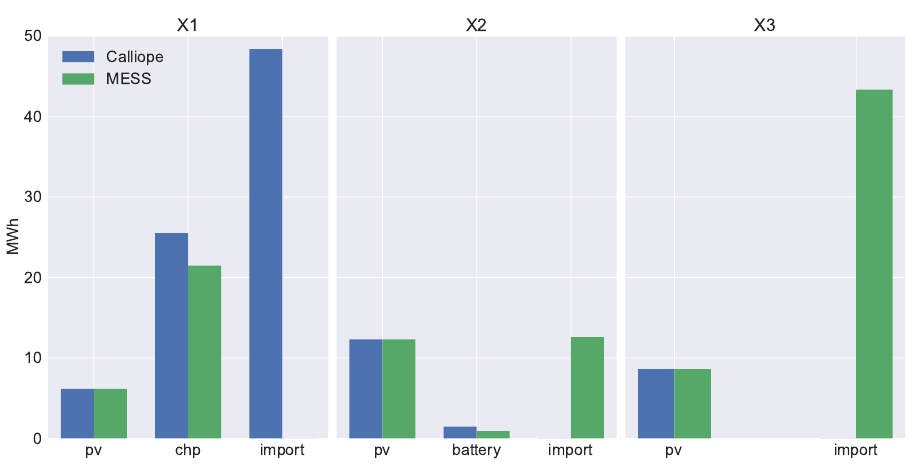
Figure 5. Annual electricity per technology source—Calliope and MESS comparison.